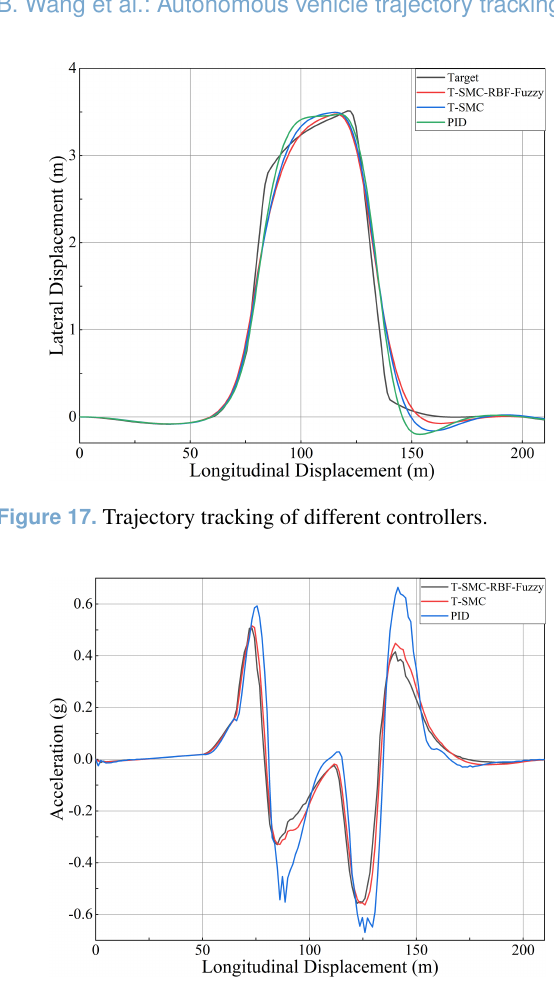
Figure 18. Acceleration of different controllers.